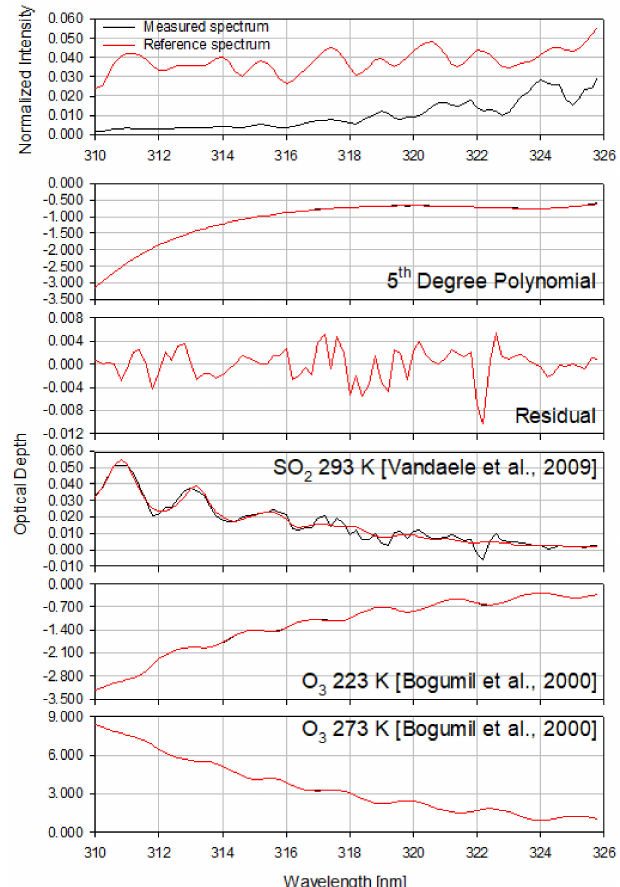
Figure 5. Example of the deconvolution of DOAS spectra for evaluating SO 2 SCDs. The black and red lines represent the absorption signal as well as the sum of the absorption signal and the fit residual, respectively. The measured spectrum represents the spectrum at 06:00 (UTC) 09 April 2016, located around Kagoshima. The reference spectrum was generated under the same conditions as the measured spectrum but without SO 2 .